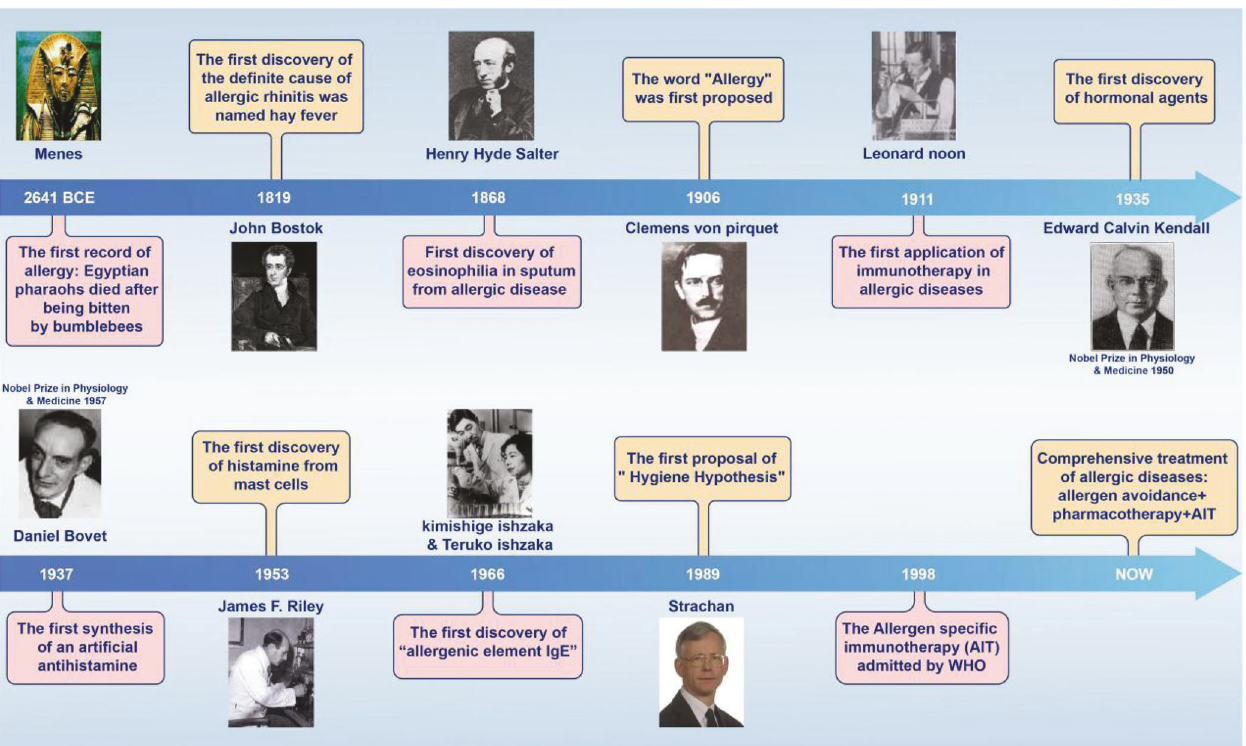
Fig. 1 Timeline of major fi ndings related to allergic diseases. Allergic reactions in Western countries were fi rst recorded in 2641 BCE, when the Egyptian Pharaoh Menes died after being bitten by a bumblebee. In 1911, Leonard Noon published an article in The Lancet , reporting a clinical paper treating pollinosis by subcutaneous injection of grass pollen extract, which marked the beginning of modern immunotherapy. In 1966, the Japanese scientist Ishizaka and his wife discovered IgE, which led to a leap in the understanding of immediate allergy. Following their discovery, IgE became a new indicator for the diagnosis of allergy